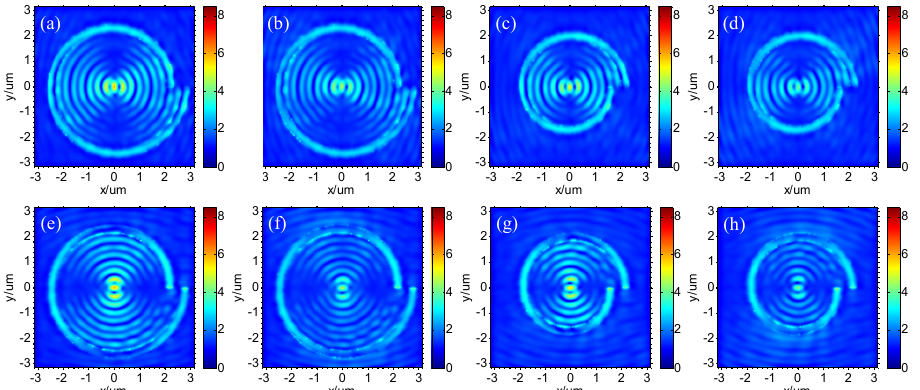
Figure 6. The electric field distribution |E| on the top surface of the plasmonic lens with different structures, illuminated by a linearly polarized beam ( λ = 633 nm ) with normal incidence from the top of the silver film, w 1 = 310 nm, w 2 = 155 nm, h 1 = 110 nm, h 2 = 45 nm, r 0 = 2000 nm. ( a ) |E| distribution when the spiraling of the slot parameter m = 1, with an auxiliary spiral slot and illuminated by an x-axis direction polarized light. ( b ) is the same as ( a ) but for the structure without an auxiliary spiral slot. ( c ) is the same as ( a ) but for m = −1. ( d ) is the same as ( c ) but for the structure without an auxiliary spiral slot. ( e – h ) are the same as ( a – d ), respectively, but with a y-axis-direction polarized beam for the incident light.